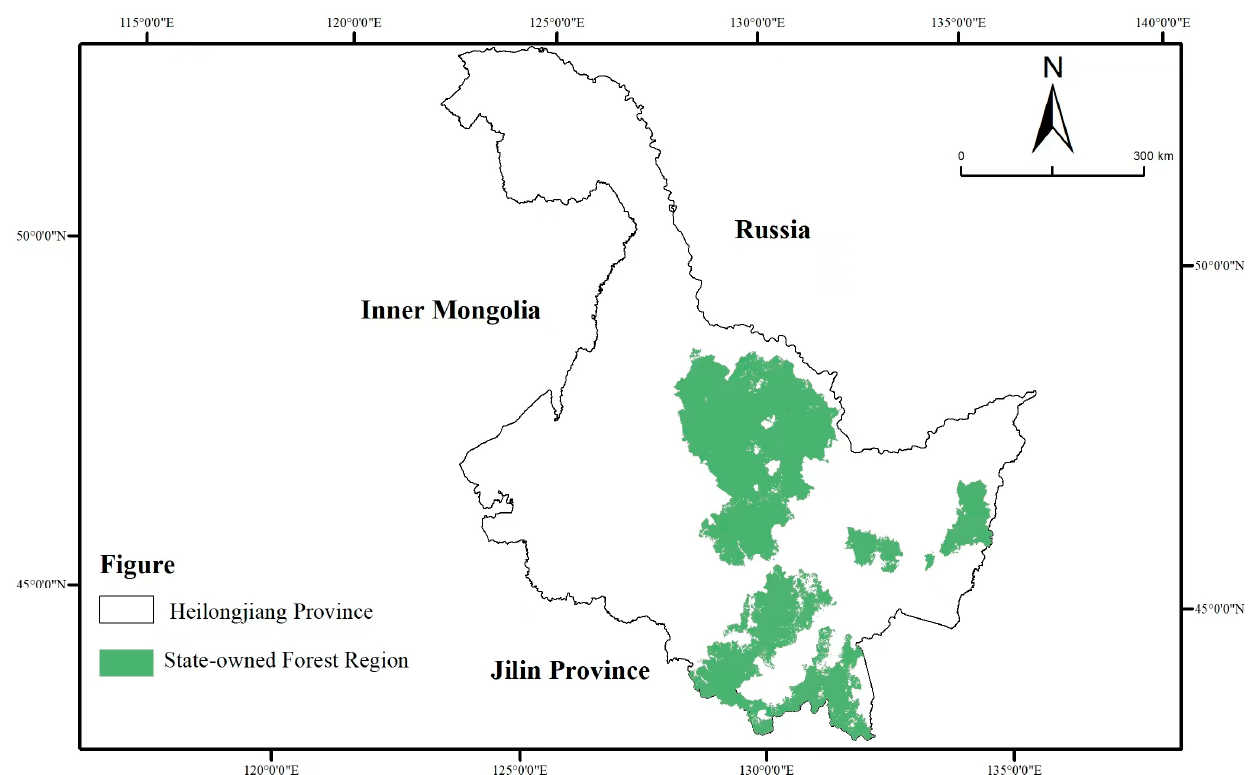
Figure 1. Regional map of state-owned forest areas in Heilongjiang Province, China.